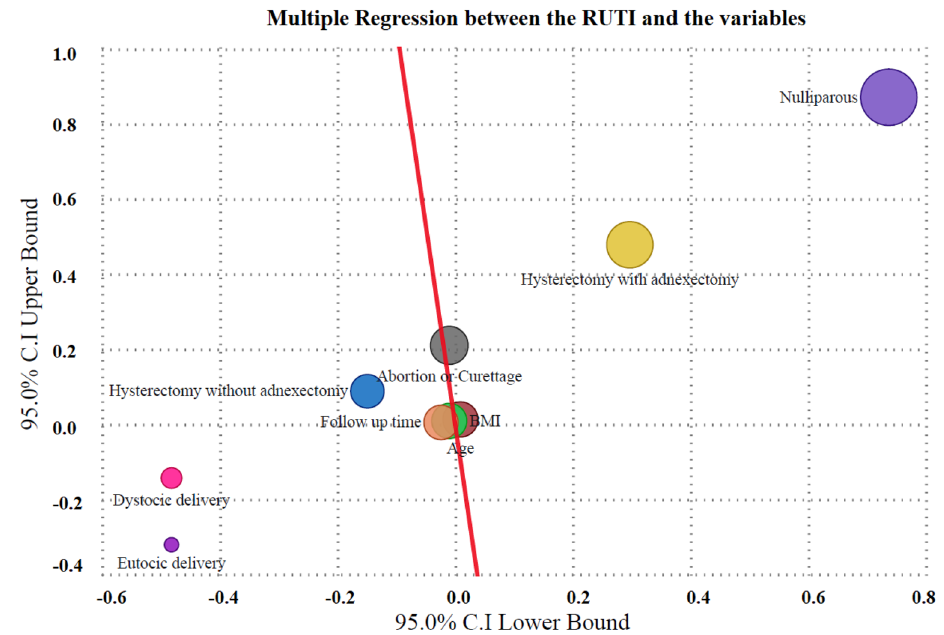
Figure 2. Mutiple regression between the RUTI and the variables.